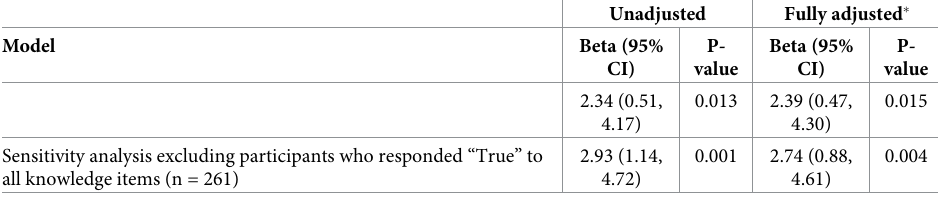
Table 2. Association between knowledge of hepatitis C virus and hepatitis C-related